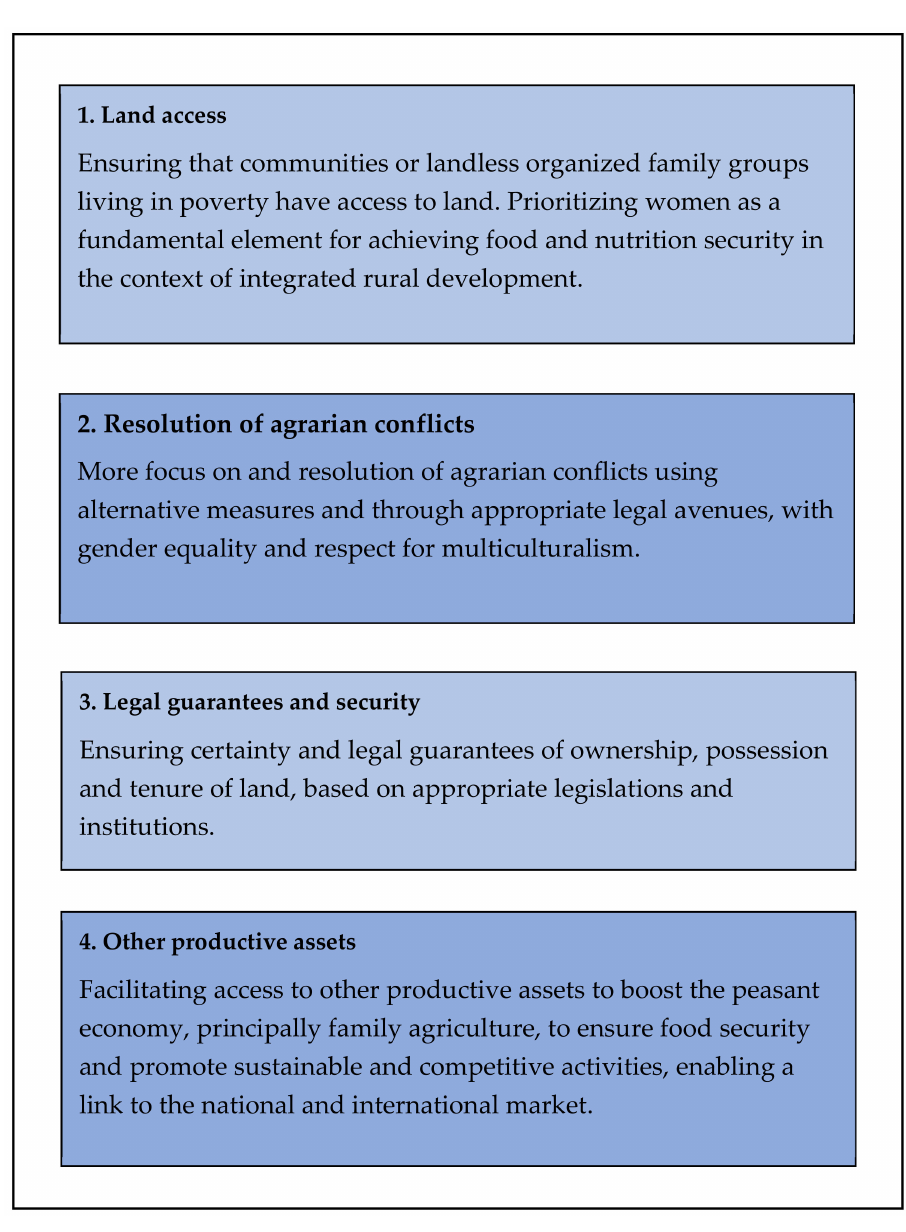
Figure 2. Axes of Guatemala’s agrarian